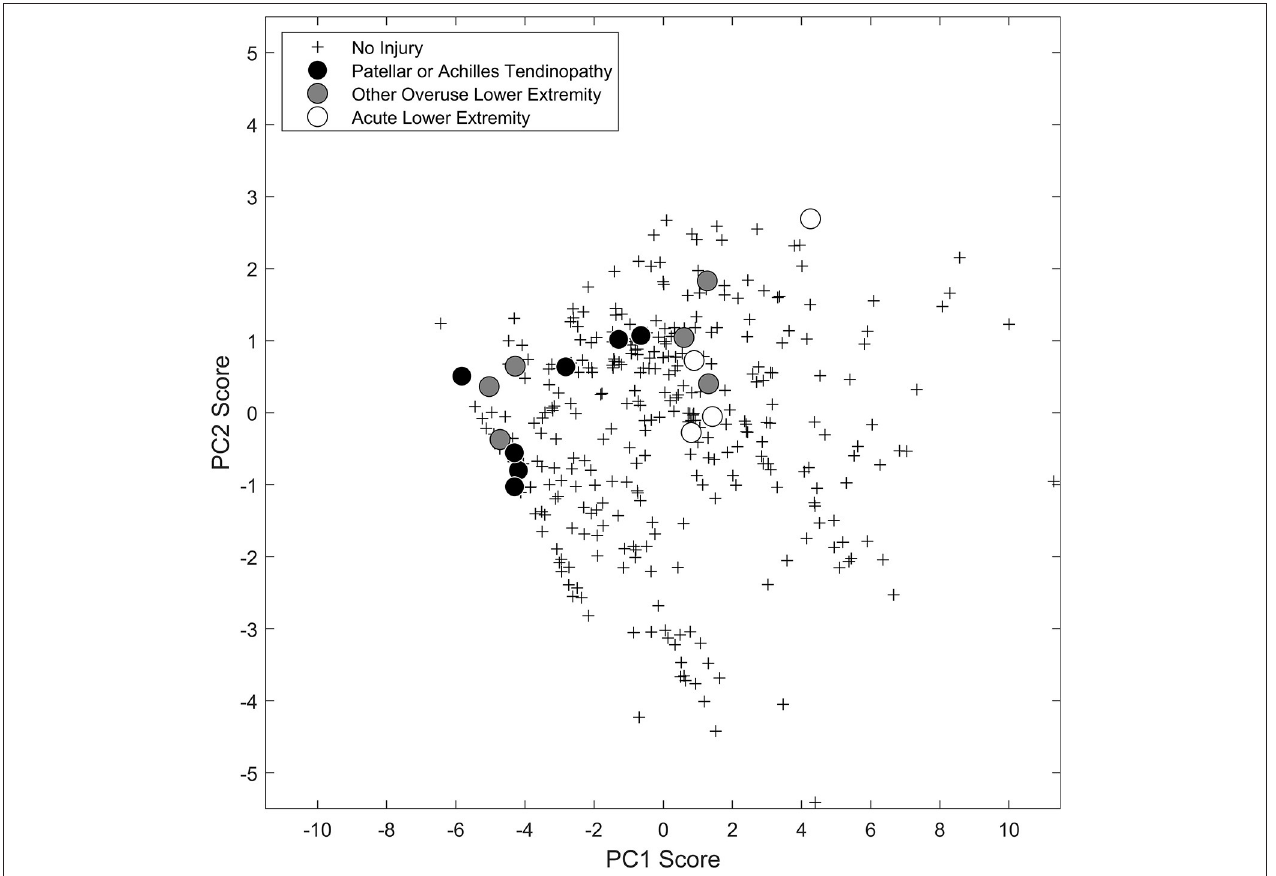
FIGURE 9 | Scatterplot of the PC1 and PC2 scores for all participant-weeks with no injury ( + ) and the week before injury for patellar or Achilles tendinopathy (black circle), other overuse lower extremity injury (dark gray circle), or acute lower extremity injury (white circle).